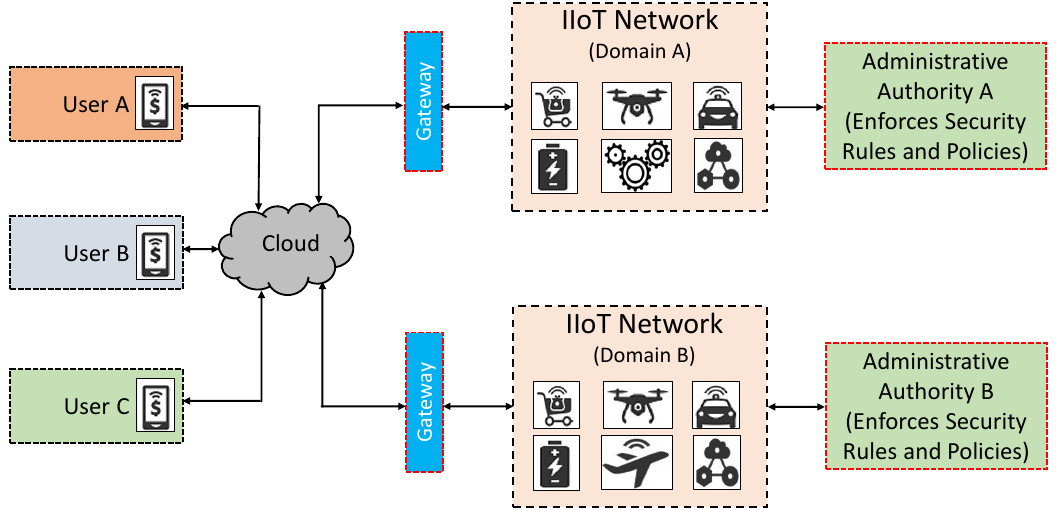
Figure 6. A view of cross-domain jurisdictions in an IIoT